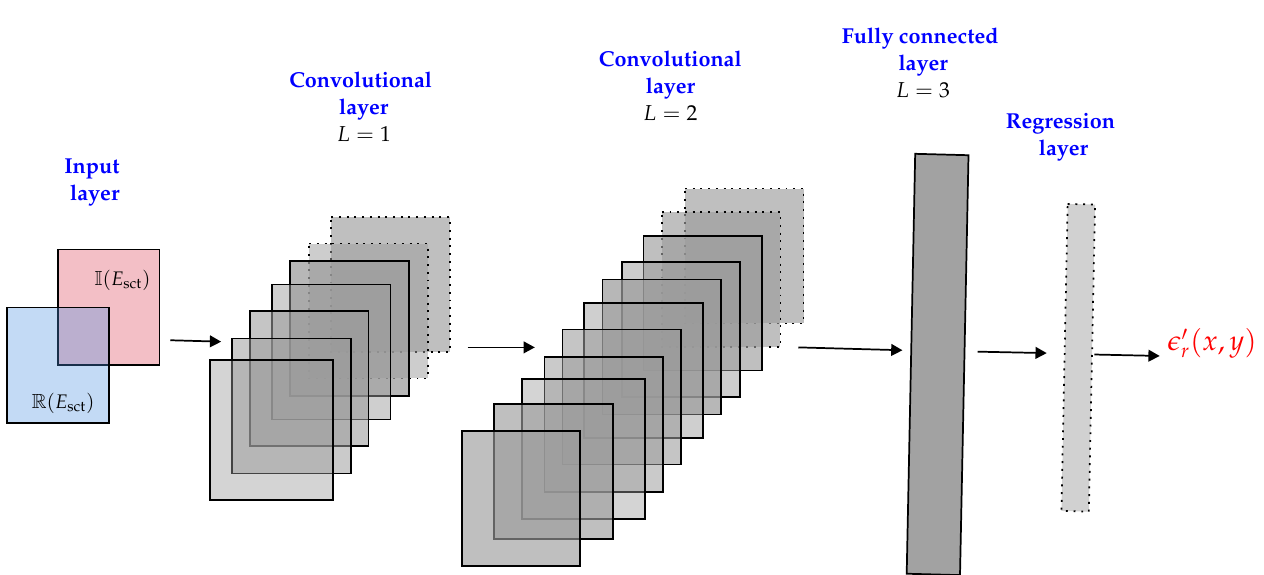
Figure 4. The architecture of the convolutional neural network used in this study. The convolutional neural network (CNN) is trained using a dataset comprising of moisture content distribution Θ m and corresponding scattered electric field parameters { } , m = 1, . . . , N m . N m denotes the number of samples in the dataset. The generation E sct m of such a dataset is described below. In the training phase, the goal is to find biases b and